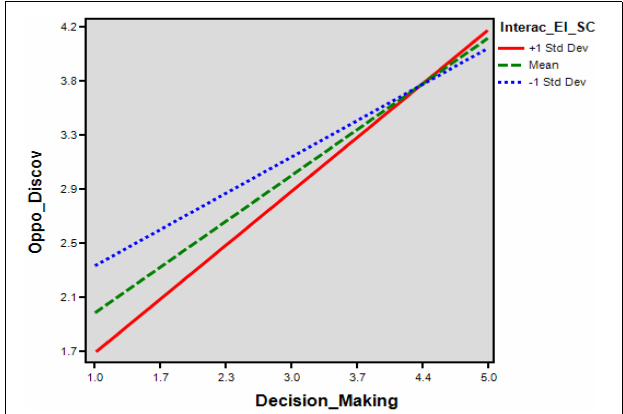
FIGURE 4 | Three-way interaction on opportunity